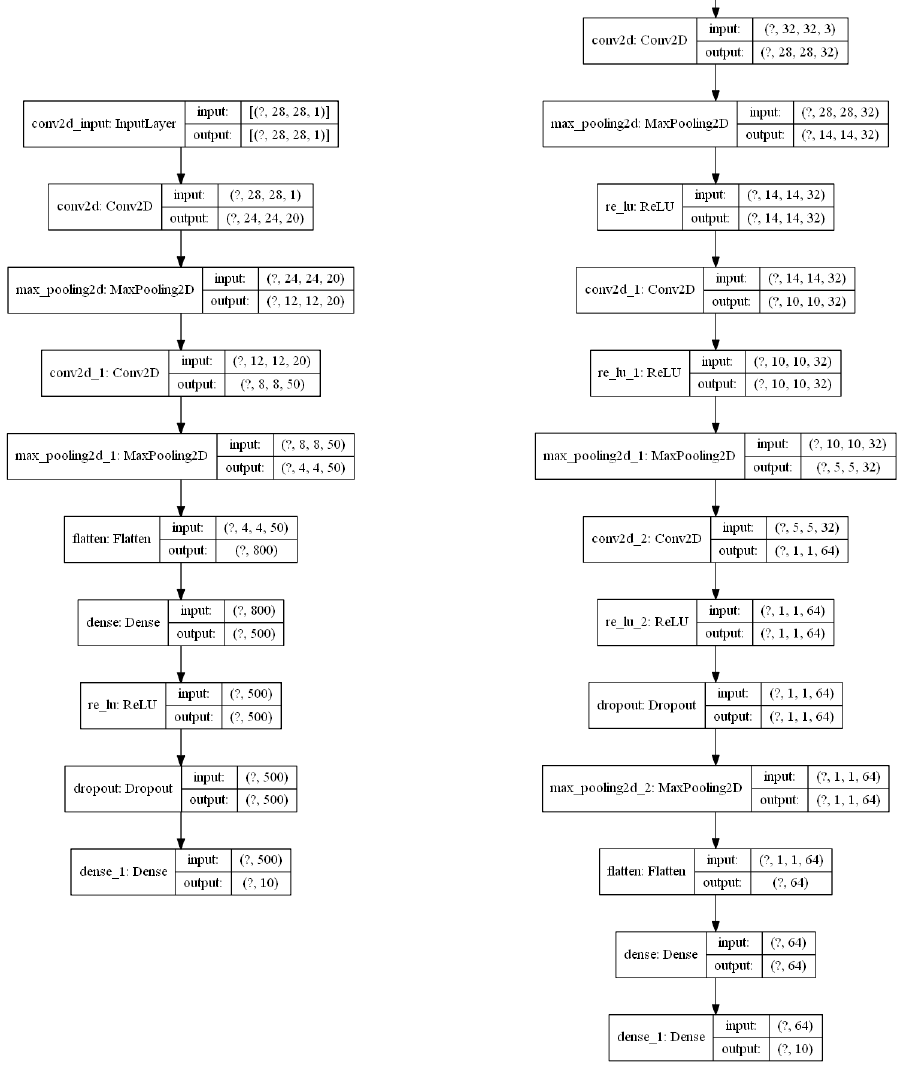
Figure 4. Example instance of MNIST/Fashion-MNIST/Semeion/USPS models ( left ) and example instance of CIFAR-10 model ( right